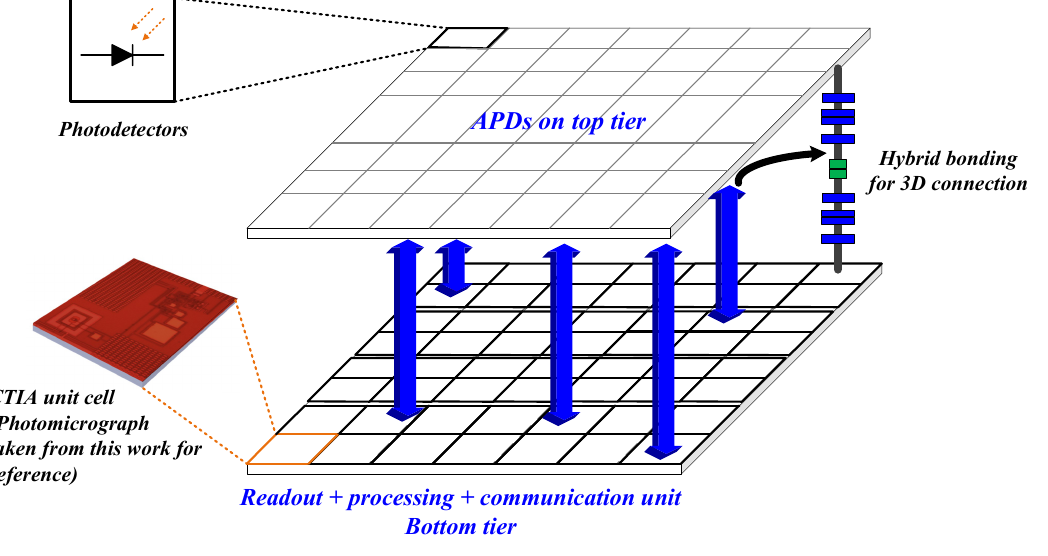
Figure 14. Conceptual representation of 3D